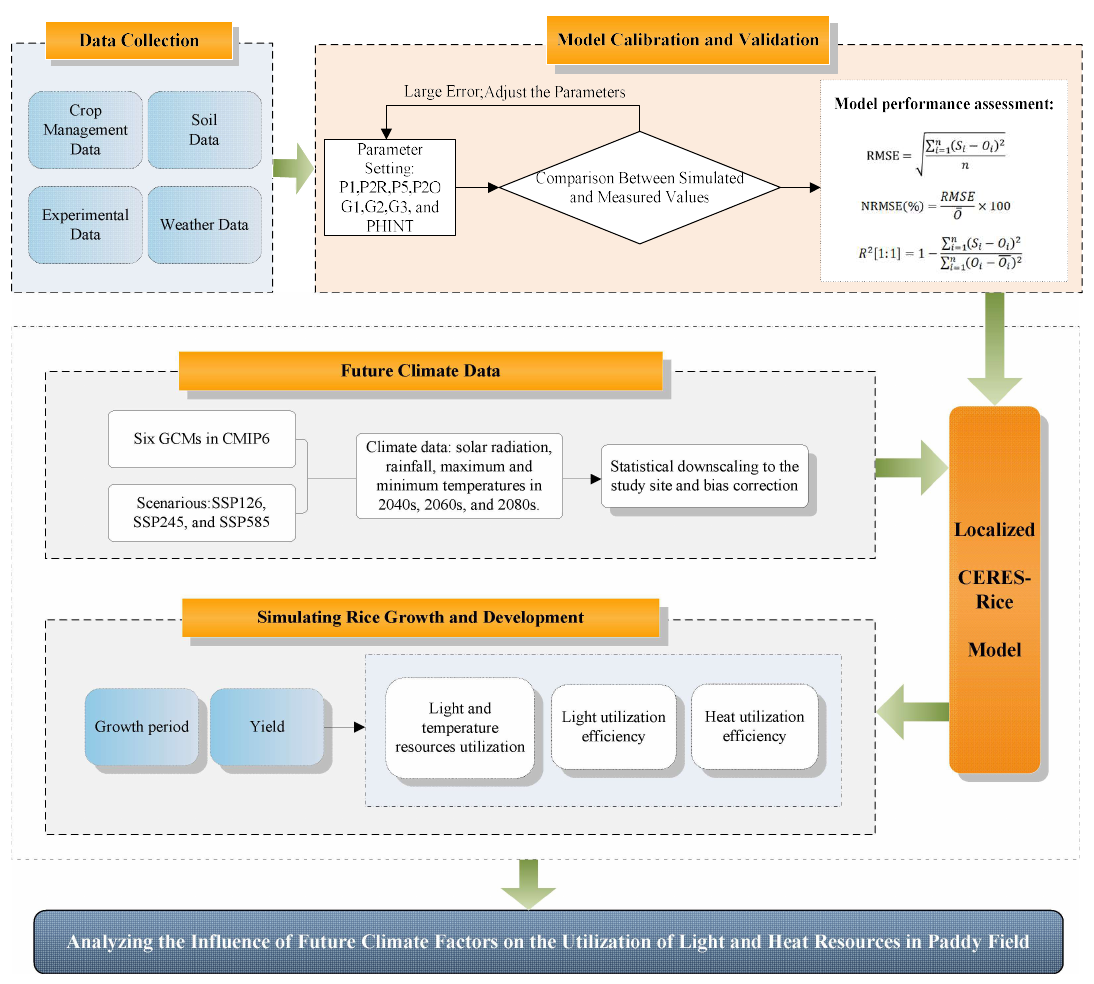
Figure 2. The framework of analysis.